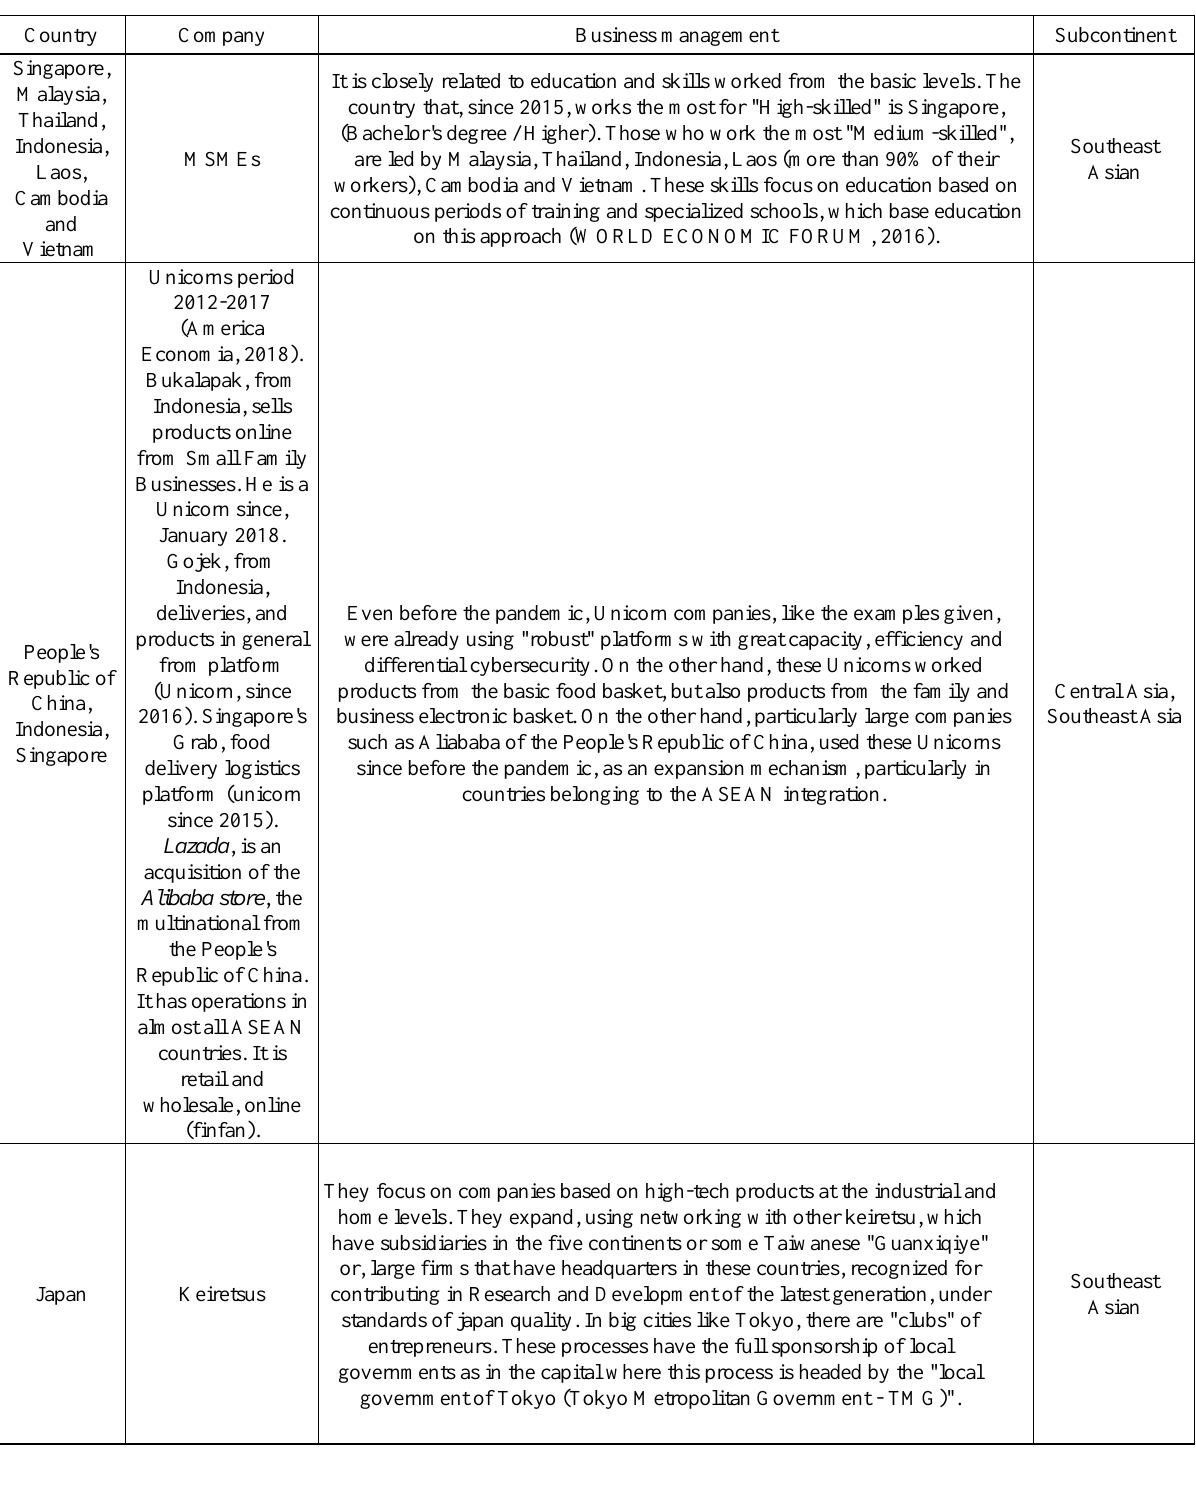
Table 1. Characteristics of pre-pandemic business and entrepreneurship